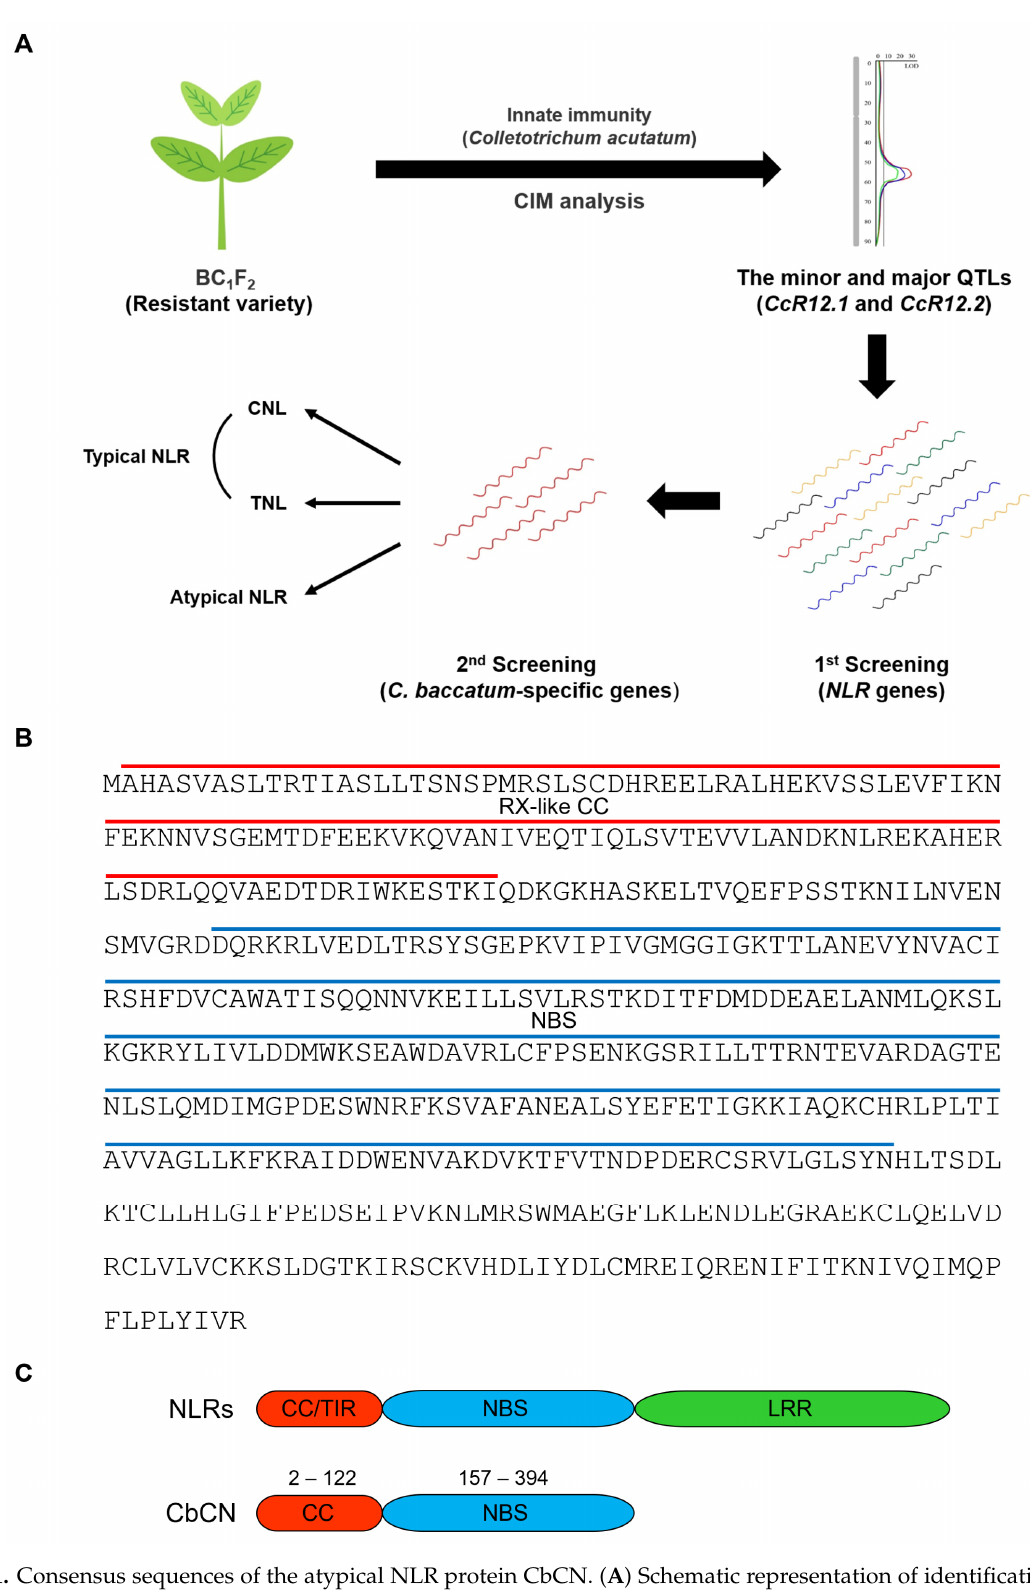
Figure 1. Consensus sequences of the atypical NLR protein CbCN. ( A ) Schematic representation of identification of the CbCN gene by genomic analysis. ( B ) Amino-acid sequences of CbCN cloned from PBC80. The 508 amino-acid sequences of the CbCN protein were analyzed and conserved domains were predicted using the InterPro program. The red line indicates the CC domain and the blue line indicates the NBS domain. ( C ) Schematic representation of a typical NLR and CbCN protein. The numbers correspond to the amino acids of the CbCN